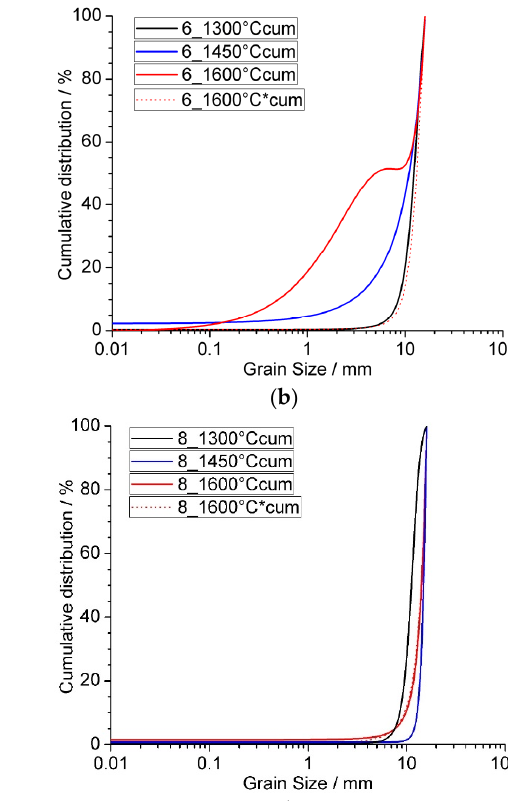
Figure 7. Cumulative curves after thermal and mechanical stressing of quartzes. ( a ) Quartz Slovakia ; ( b ) quartz Spain ; ( c ) quartz Russia ; ( d ) quartz Macedonia.